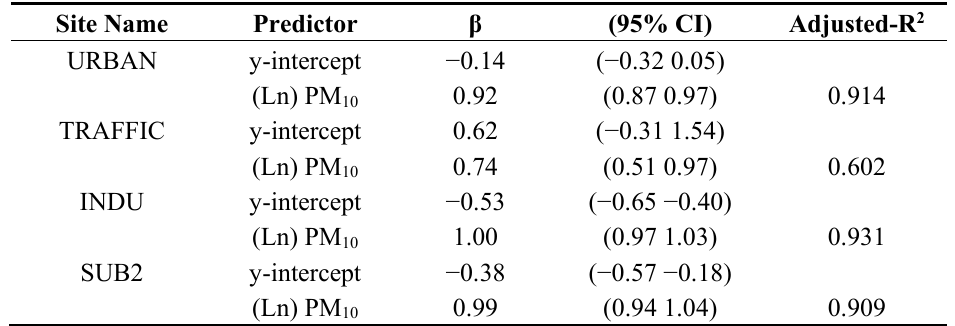
Table 3. Site-specific model of PM 2.5 (outcome) as a linear function of PM 10 (predictor), adjusting for temperature and wind speed.